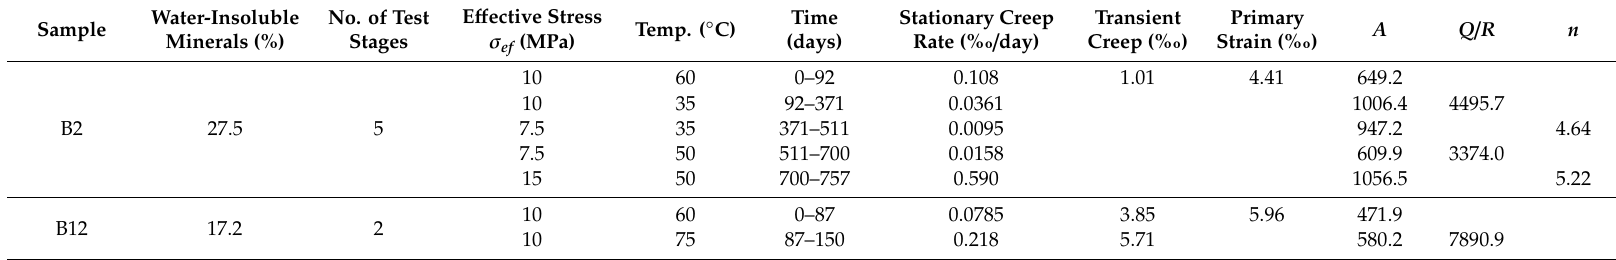
Table A2. Load-thermal conditions and the results of the rheological tests—the Brown Zuber unit samples (according to [58,62]).